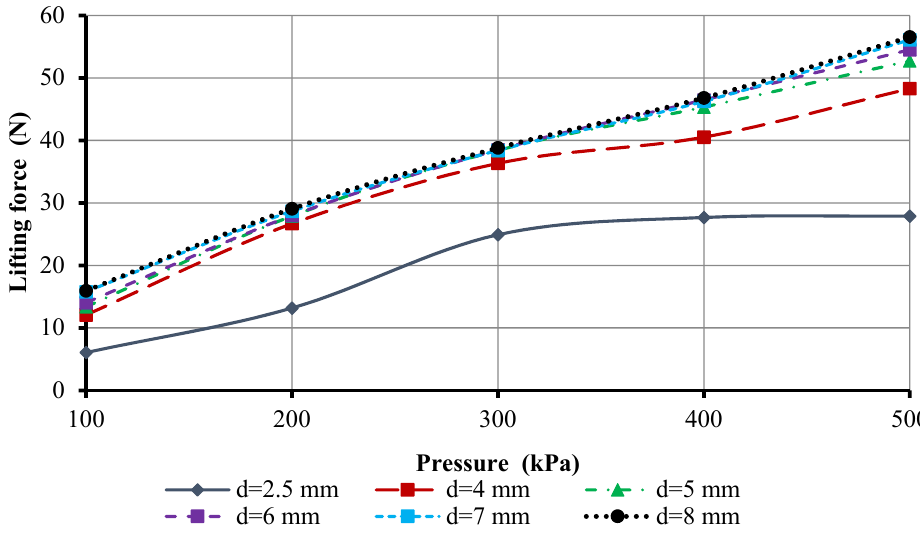
Figure 13. Influence of supply pressure on BGD lifting force at different diameters of fitting con- striction.